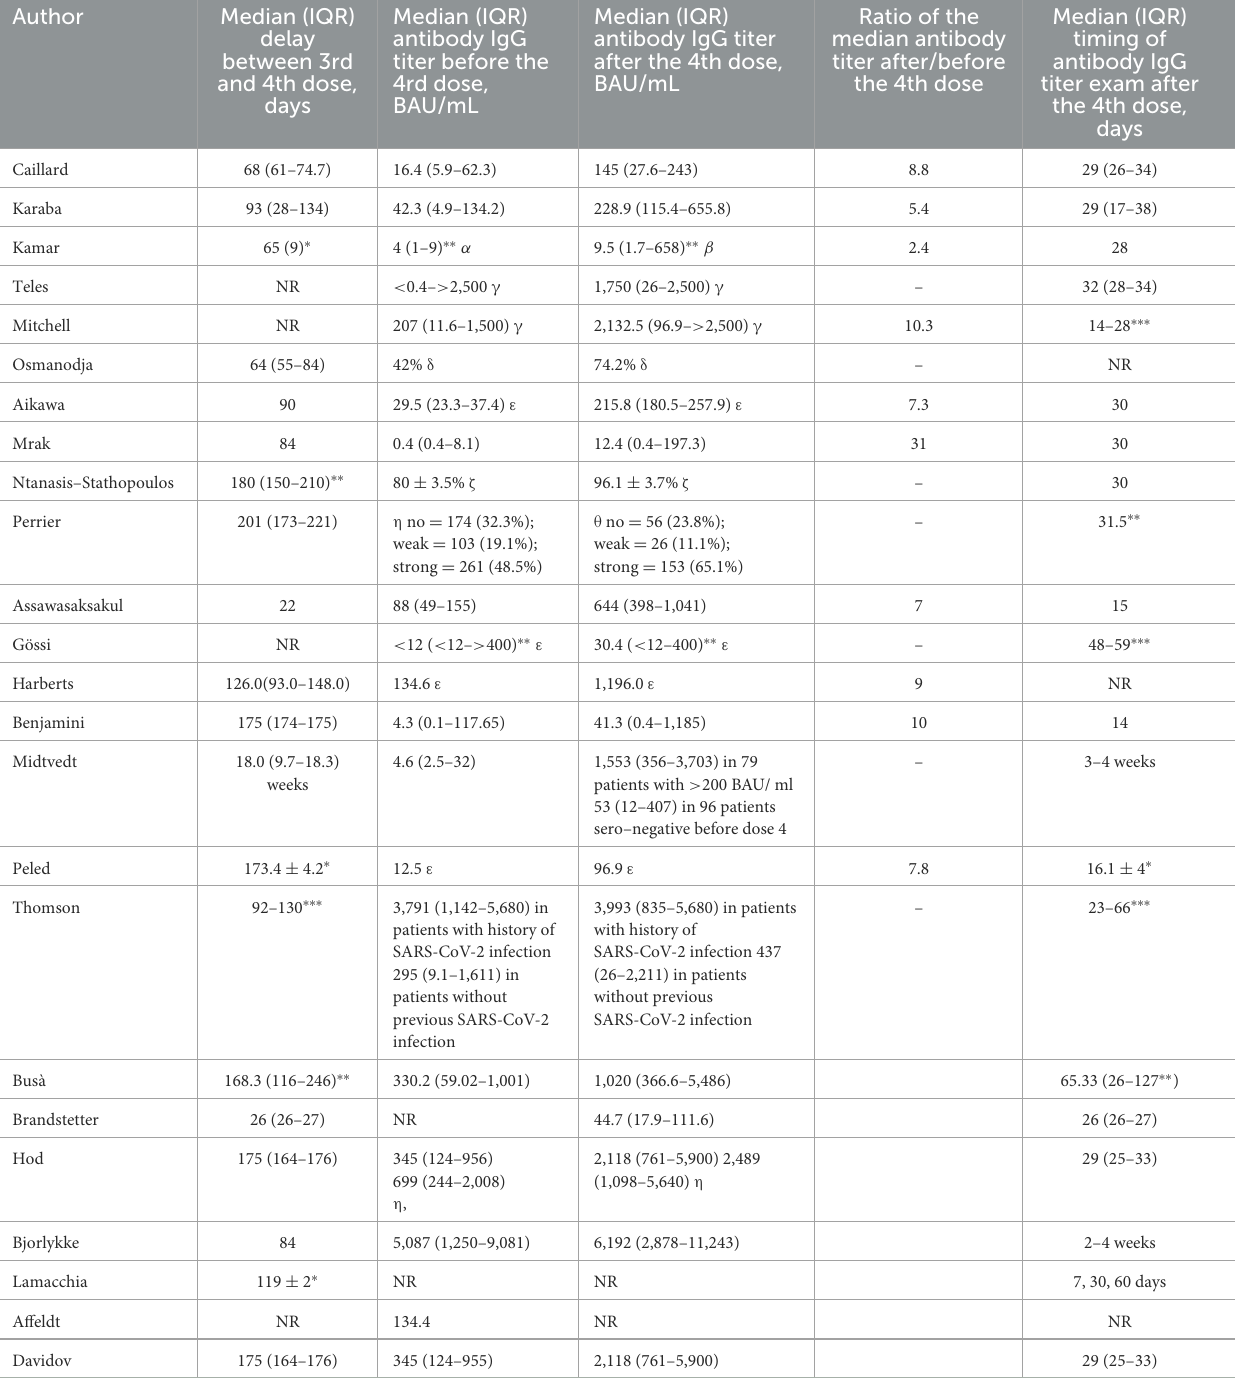
TABLE 4 Immunological outcomes after 4th dose of